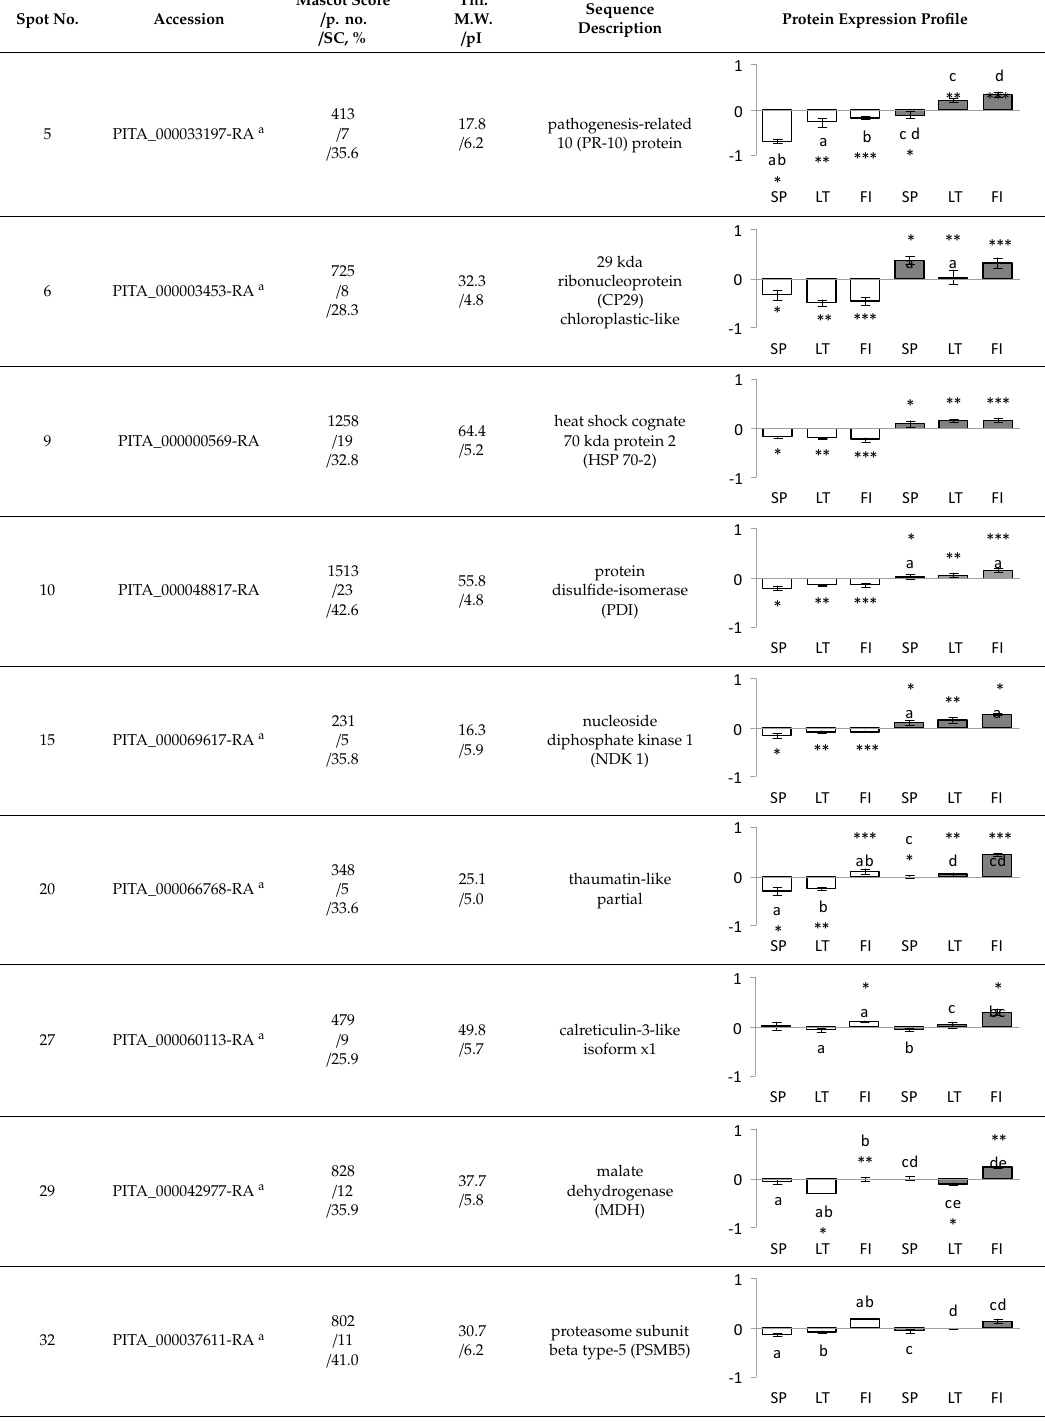
Table A1. Proteins differentially expressed in seedlings of the different populations of Scots pine under active growth conditions (white bars) and upon acclimation treatment (grey bars). Mascot Score Accession Spot No.